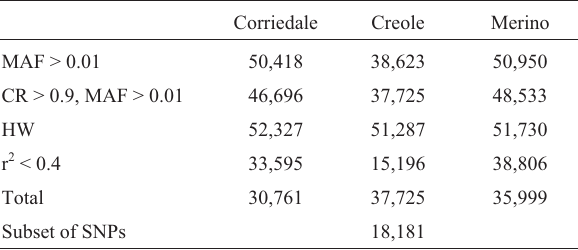
Table 3 - Subsets of the 52,413 autosomal SNPs per breed that met the es- tablished criteria for the population structure analysis. Corriedale